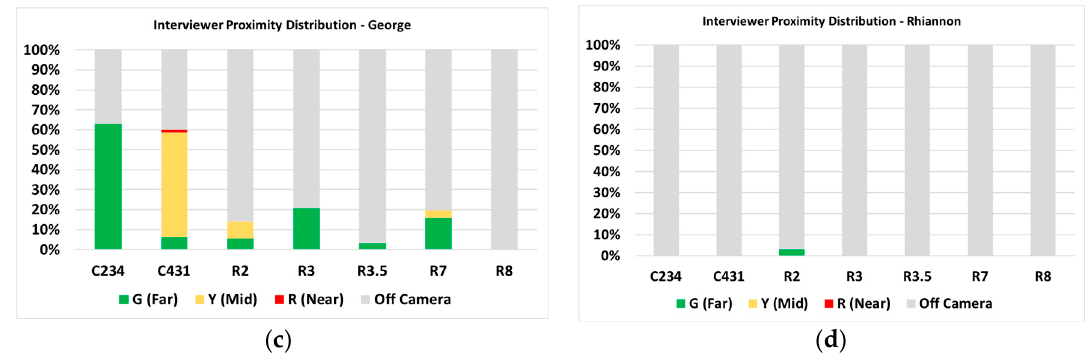
Figure 8. Interviewer proximity distributions during seven tasks: ( a ) Alyssa; ( b ) Gabby; ( c ) George; ( d ) Rhiannon.